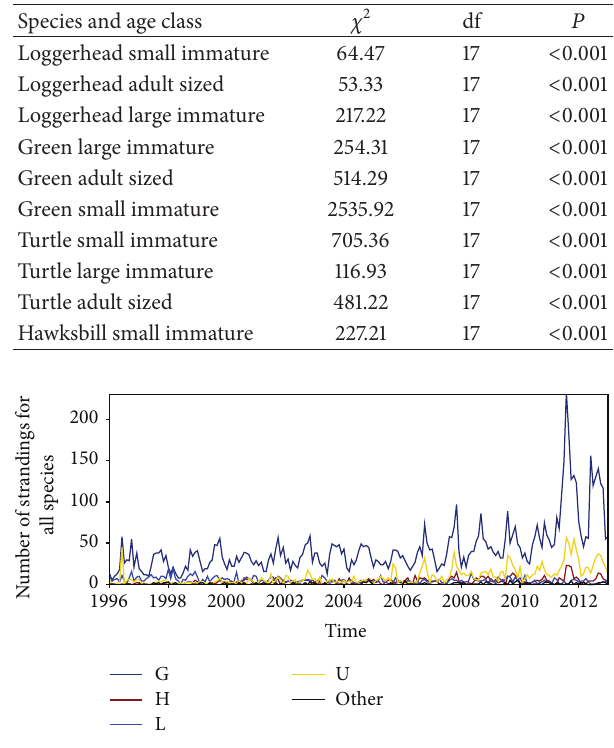
Figure 2: Total number of marine turtle strandings reported to StrandNet on the eastern Queensland coast for each species. G: Chelonia mydas . H: Eretmochelys imbricata . L: Caretta caretta . U: unidentified turtle. Other: Chelonia mydas agassizi , Dermochelys coriacea , Natator depressus , Lepidochelys olivacea, and Caretta caretta × Chelonia mydas